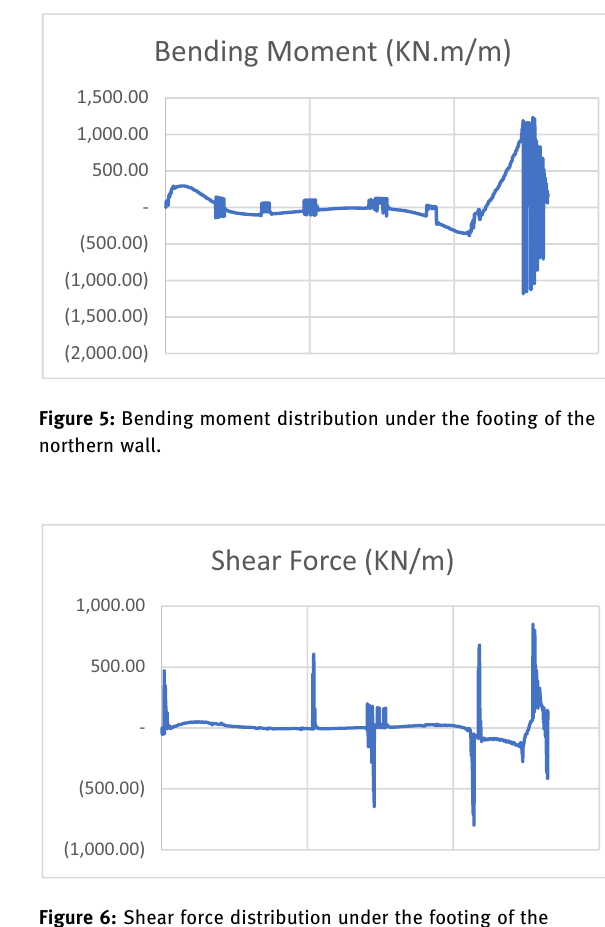
Figure 6: Shear force distribution under the footing of the northern wall.